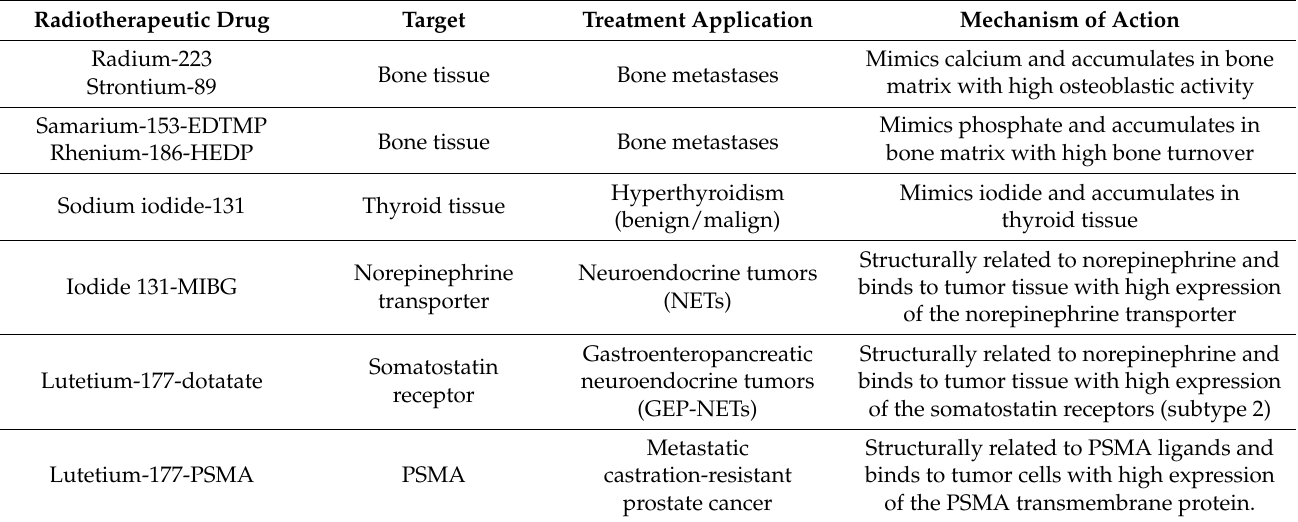
Table 1. Overview of target organs, treatment applications, and mechanisms of action of radiophar- maceuticals included in this review